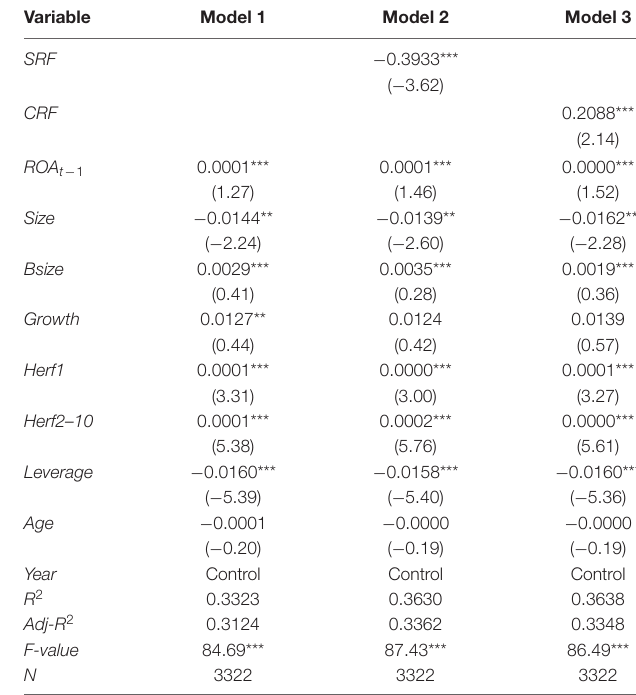
TABLE 3 | Board faultlines and innovation strategy